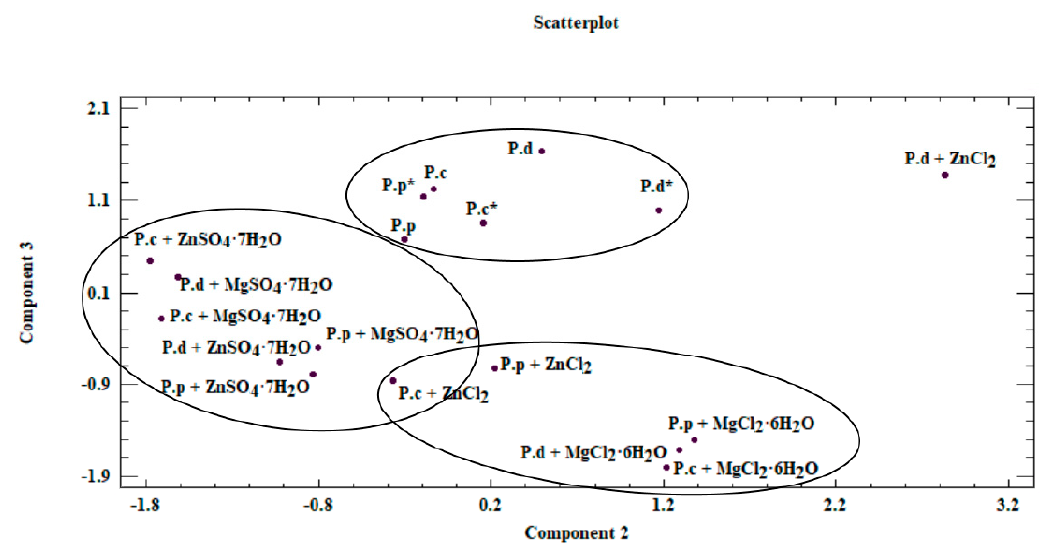
Figure 5. Scatterplot—graph presenting similarities between analyzed mycelium from in vitro cultures and fruiting bodies of Pleurotus species obtained on different culture media (P.c— P. citrinopileatus fruiting bodies, P.d— P. djamor fruiting bodies, P.p— P. pulmonarius fruiting bodies, *—mycelium obtained on a medium without the addition of inorganic salt).